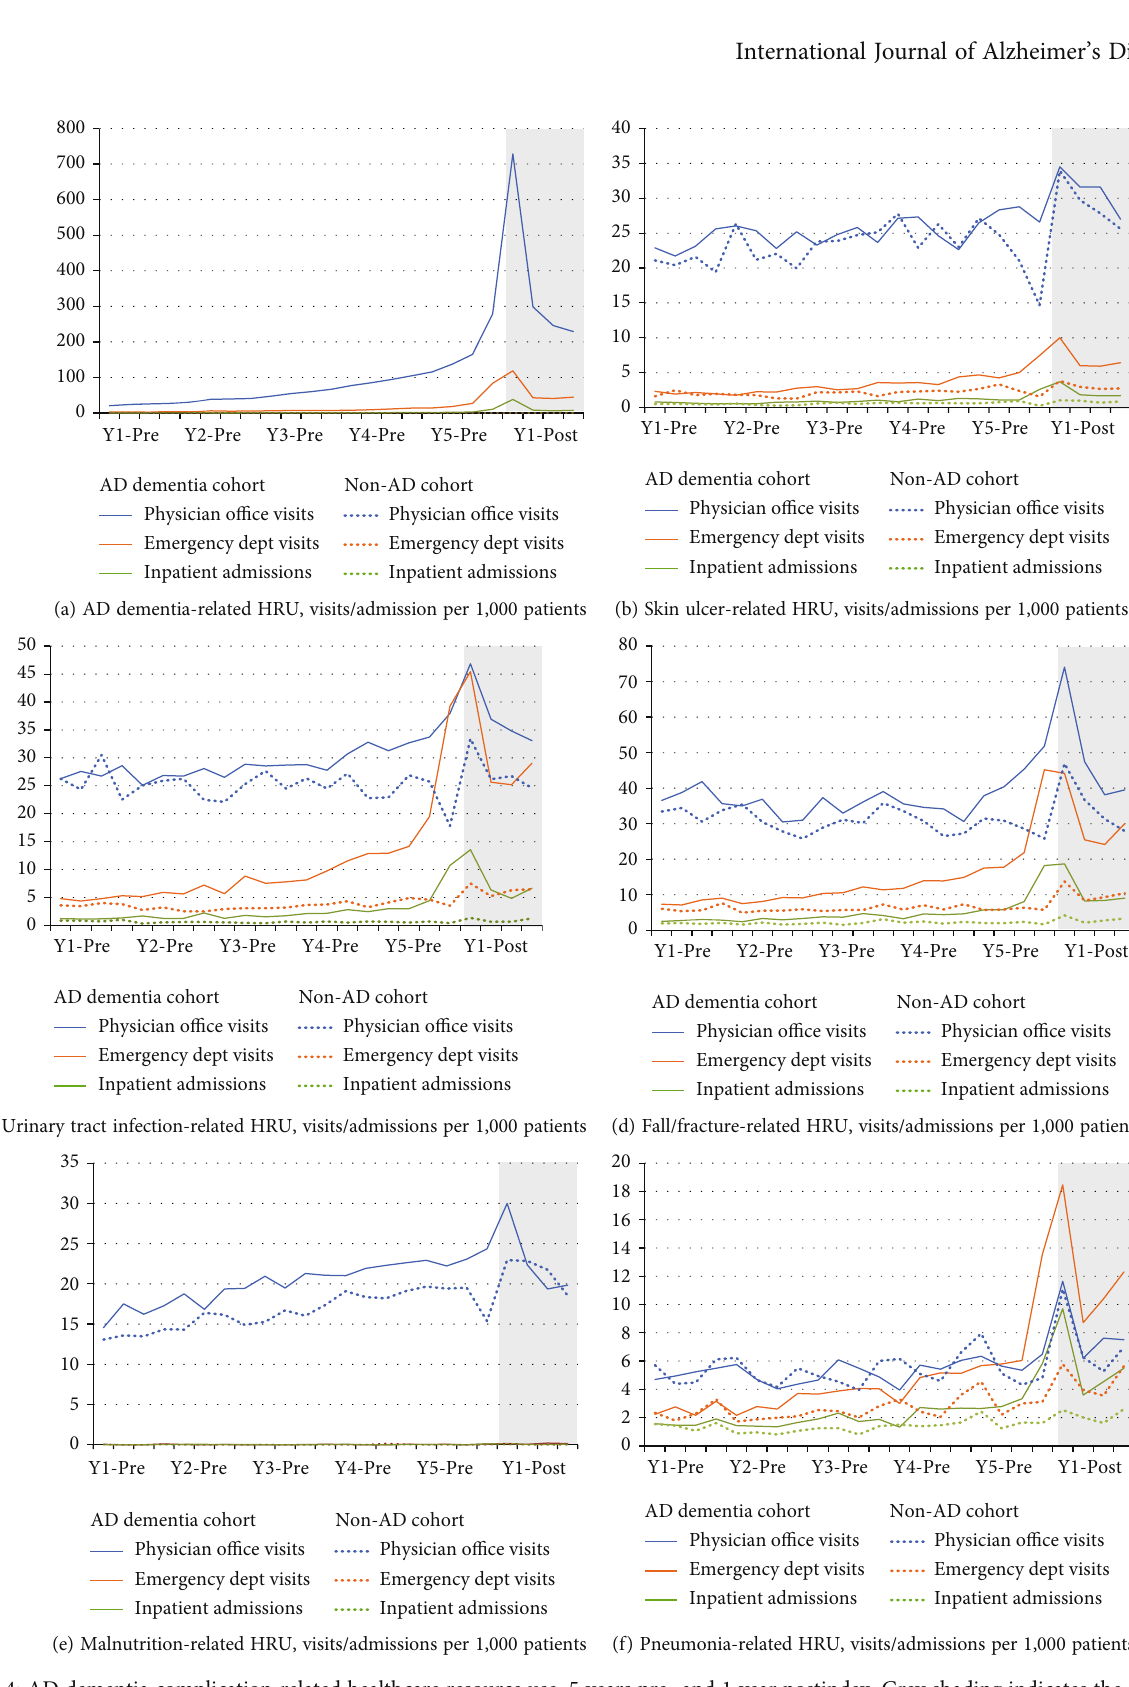
Figure 4: AD dementia complication-related healthcare resource use, 5 years pre- and 1 year postindex. Grey shading indicates the 1 year postindex